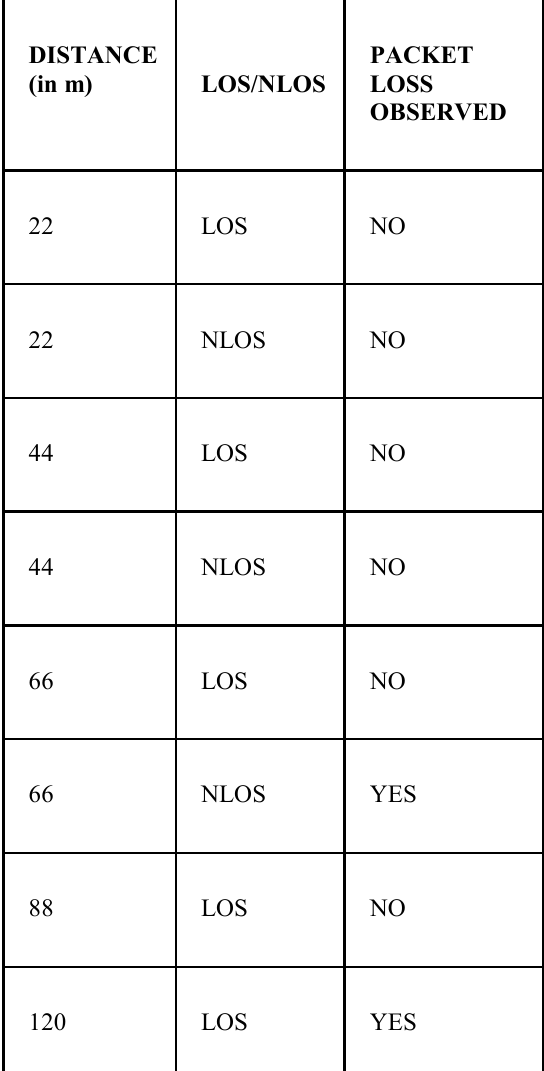
Fig. 8. LoRa receiver output display on Arduino IDE